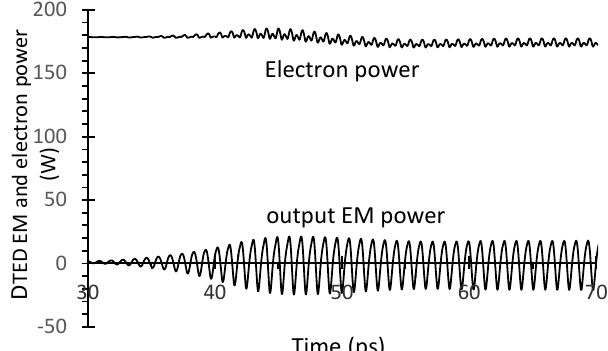
Figure 3: Transient electron and DTED output EM power evolutions (L DTED = 88 µm, V DC = 9 V).